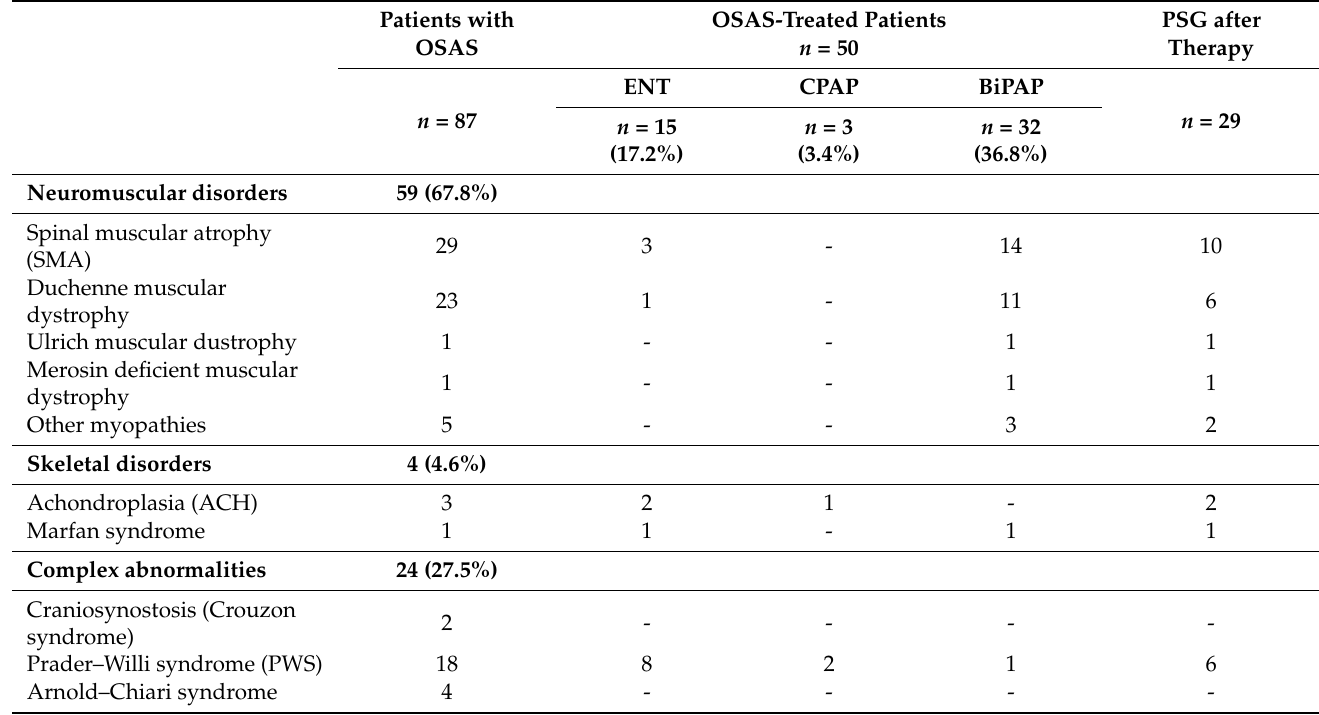
Table 4. The therapeutic approach and post-therapy follow-up in the study groups. Patients with